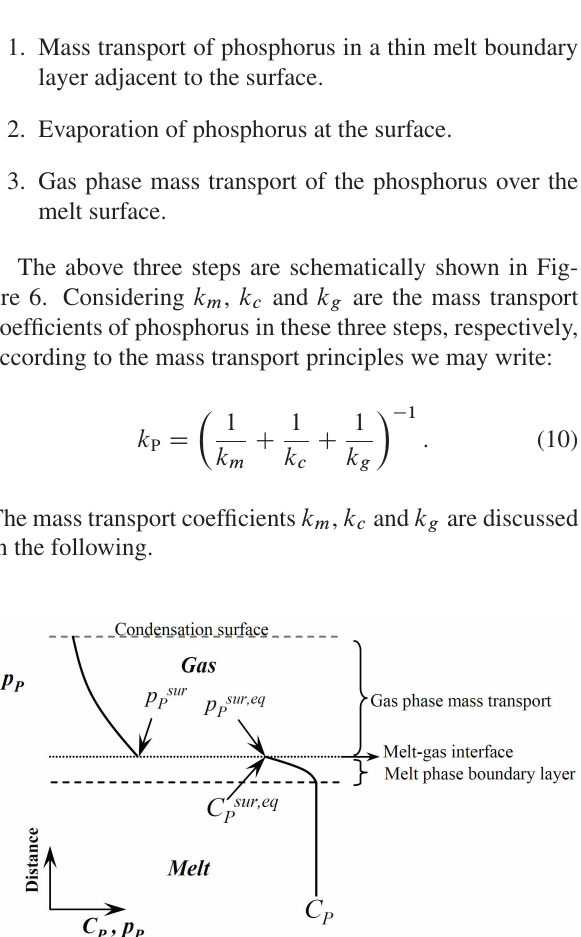
Figure 5. The changes of phosphorus concentration with refining time for different initial phosphorus concentrations.